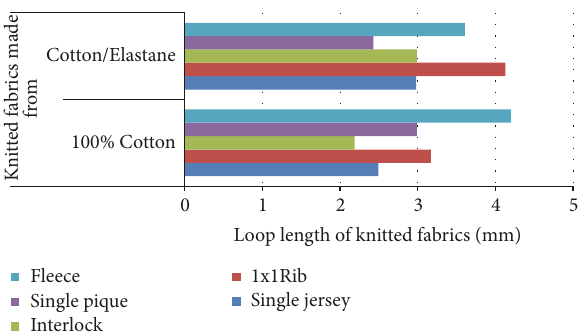
Figure 1: Loop lengths of knitted fabrics made from 100% cotton and cotton/elastane